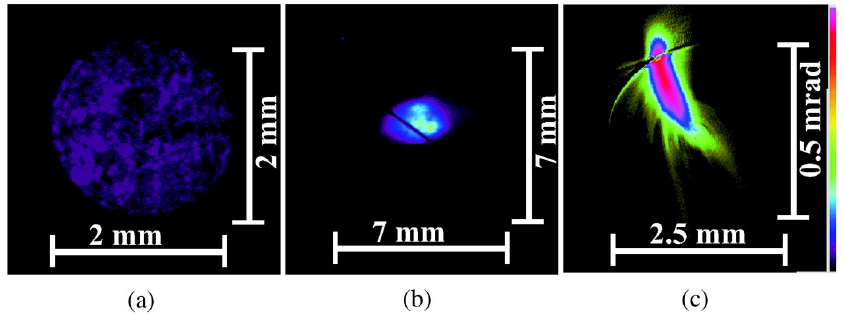
FIG. 8. (Color) Gaussian with increased flatness. (a) The laser intensity profile, (b) the electron beam profile at HPOP-UP1 location, (c) the tomographic recovery of the electron beam’s transverse phase